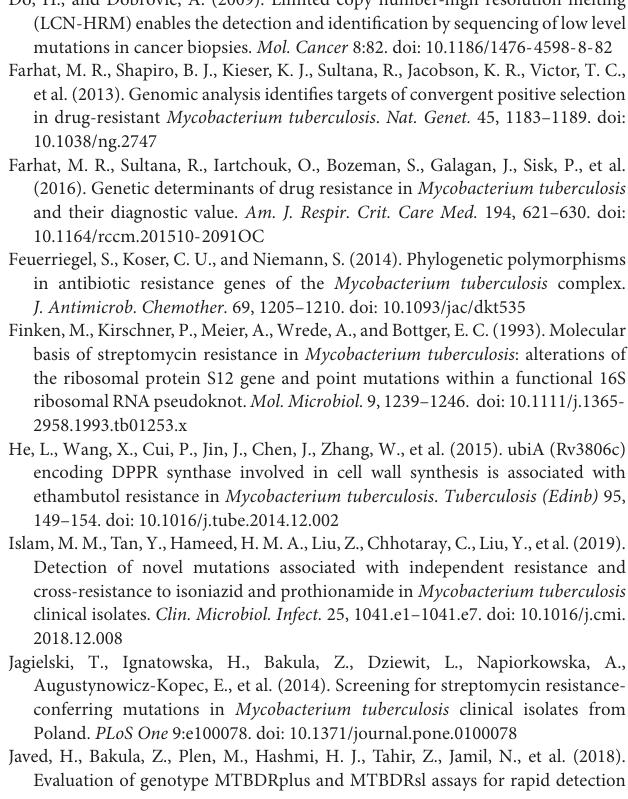
multi-drug resistant isolates. Table S7 | Mutation characterizations of rpoB among 137 MDR isolates from China. Table S8 | Mutation characterizations of gidB among 100 streptomycin resistant isolates and 83 streptomycin susceptible isolates from China. Table S9 | Mutation characterizations of embABC among 77 ethambutol resistant isolates and 106 ethambutol susceptible isolates from